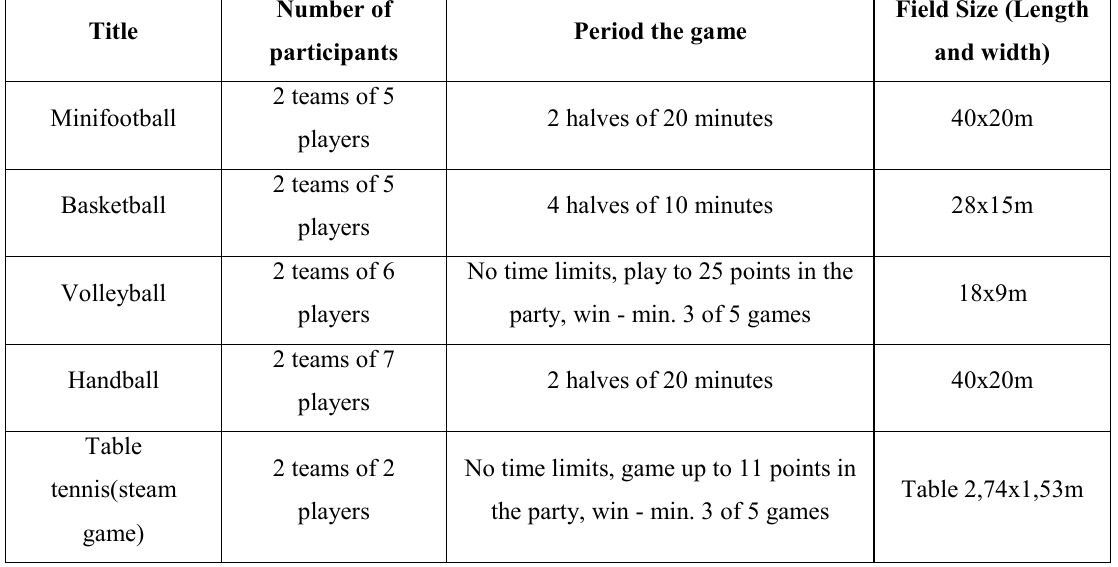
Characteristics of team sports games that have been used in extracurricular educational work for the development